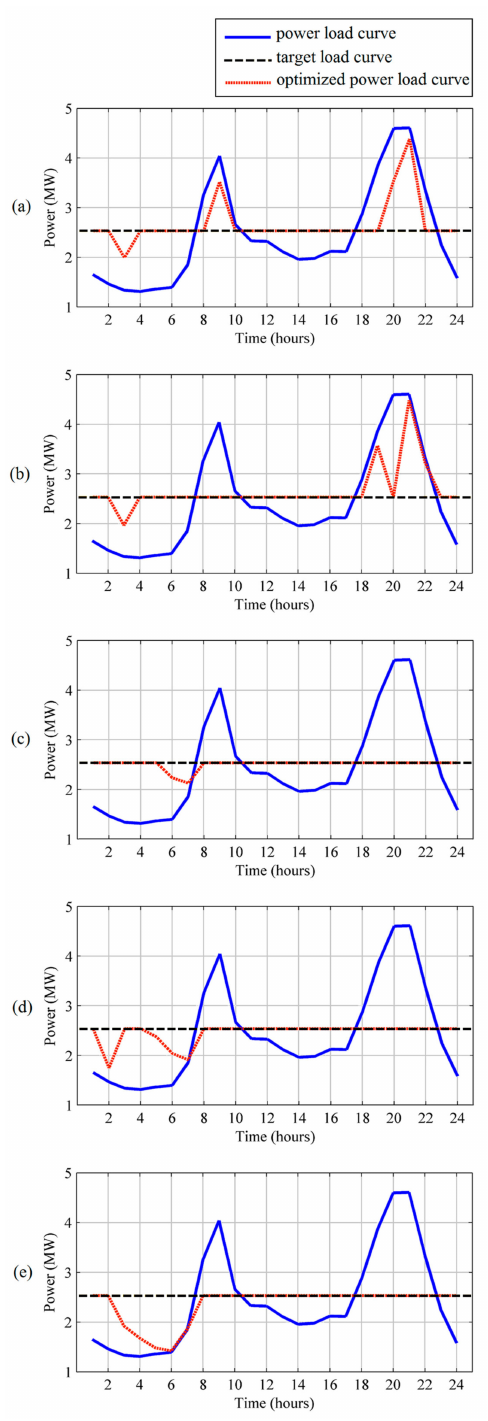
Figure 7. Optimized power load curves with 55% TLC pct and SOC i,ave of ( a ) 40%, ( b ) 50%, ( c ) 60%, ( d ) 70% and ( e )